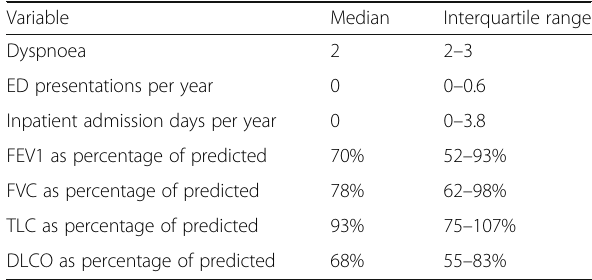
Table 2 Rates of ordinal and continuous symptoms, healthcare utilisation and pulmonary function test